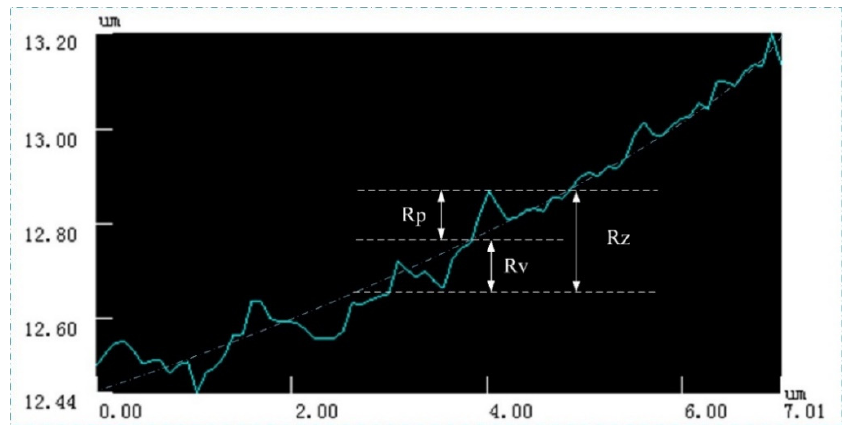
Figure 6. The CSPA with a 30 μ m period. ( a ) Two-dimensional topography and ( b ) three-dimensional topography and both the surface profiles indicating the height or depth by ( c ) and the featured horizontal size by ( d ).